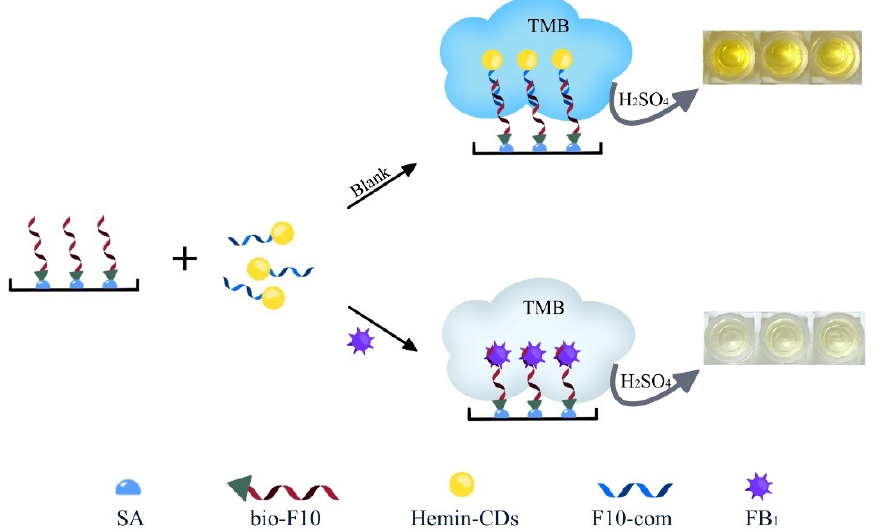
Scheme 1. Schematic diagram of the ELONA method based on aptamer complementary chains and CDs